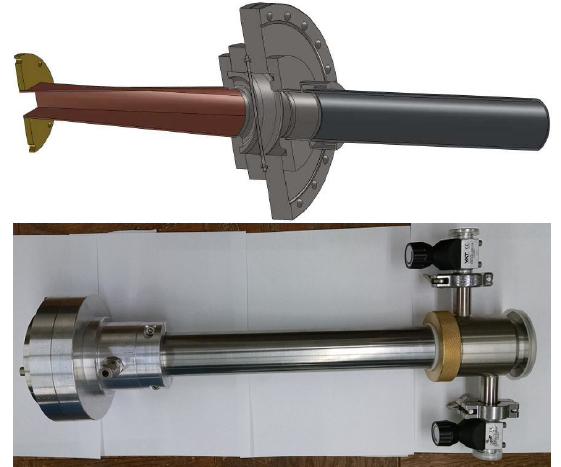
Fig 3. Antenna design for 12cm porthole (top) shown with bellows assembly and linear actuator hidden. Antenna for 5cm porthole (bottom) uses differentially pumped o-ring seal.